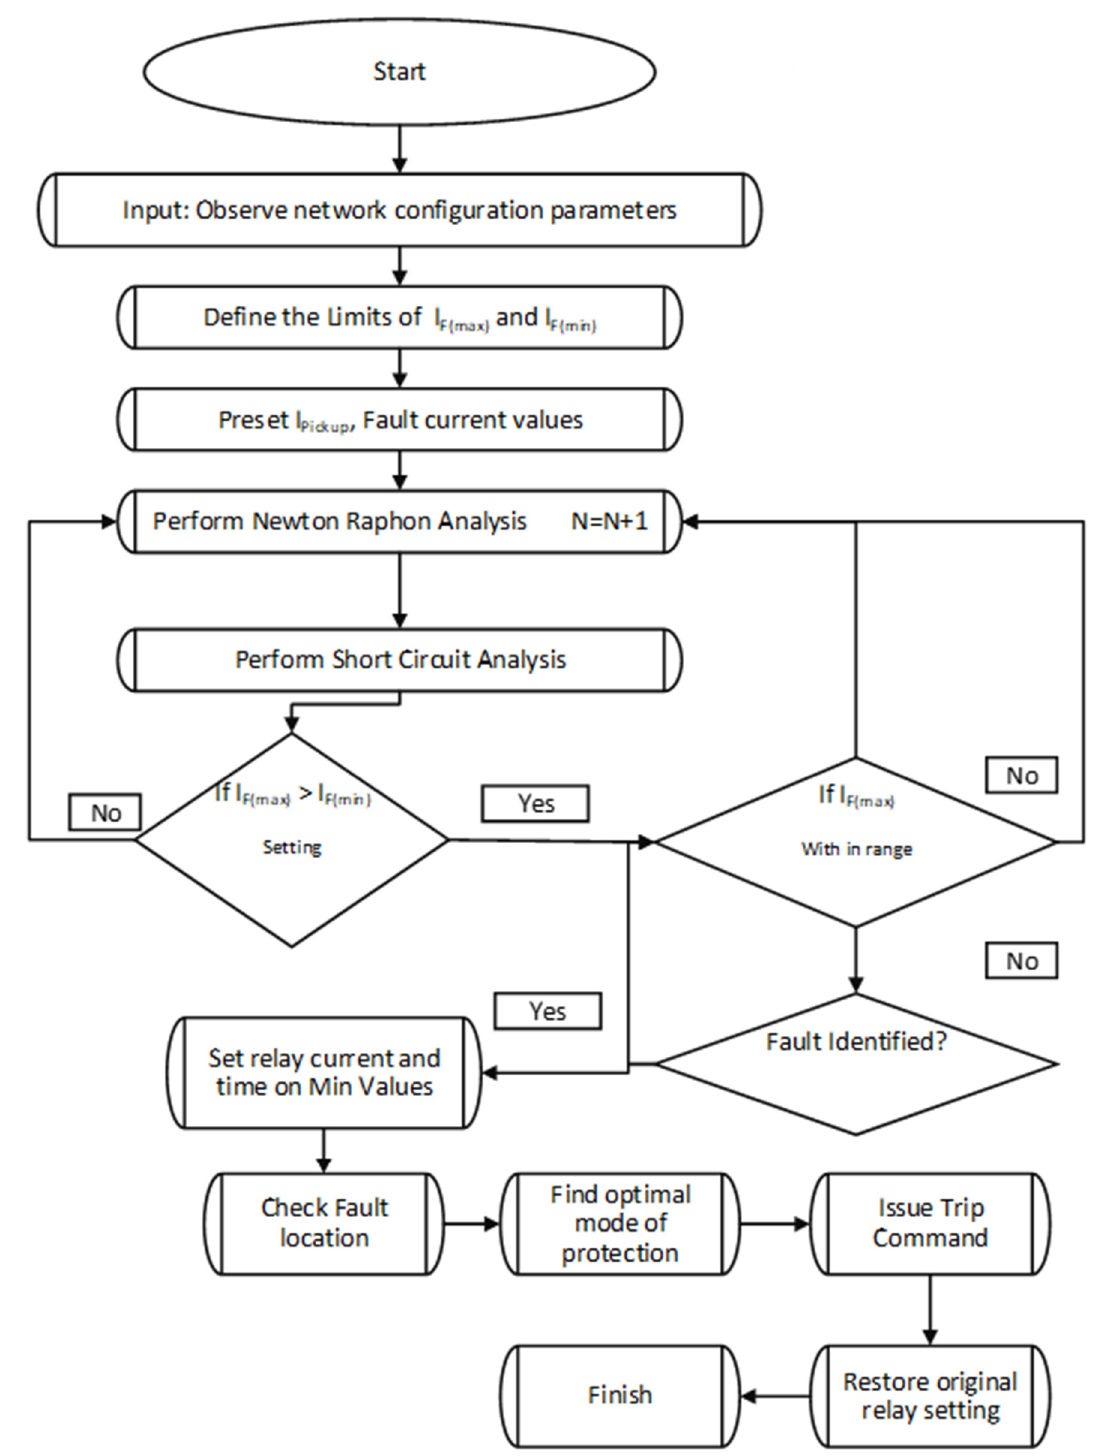
Figure 4. Flowchart of current relay for coordination in the protection zone.